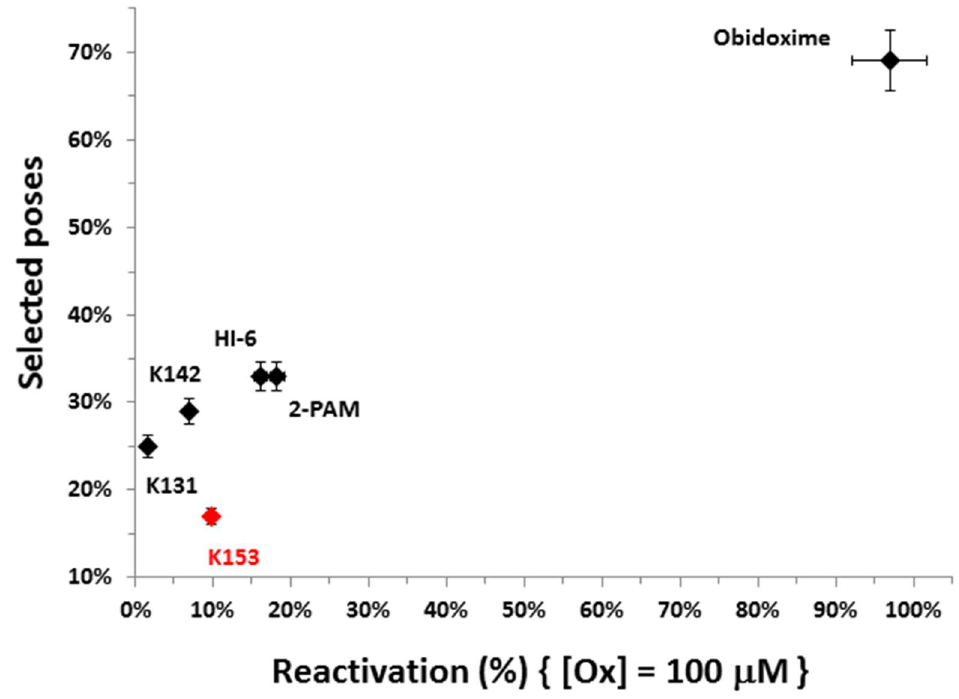
Figure 6. Correlation between the percentage of poses at the near attack conformation (NAC) and the percentage of reactivation for the oximes (Ox) for the complex Hss AChE/POX.